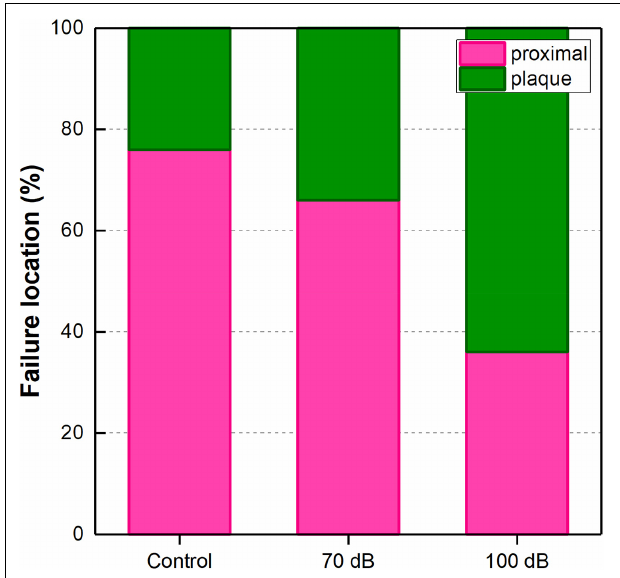
FIGURE 4 | Effects of anthropogenic noise exposure on failure occurrence (%) at each location of byssal thread newly produced by the thick shell mussel Mytilus coruscus ( n = 5 per group, χ 2 = 35.92, df = 2, p < 0.0001).